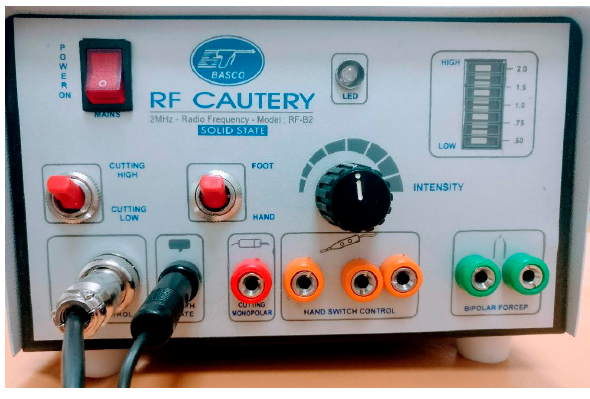
Figure 1. Radiofrequency (RF) cautery equipment used in the procedure.